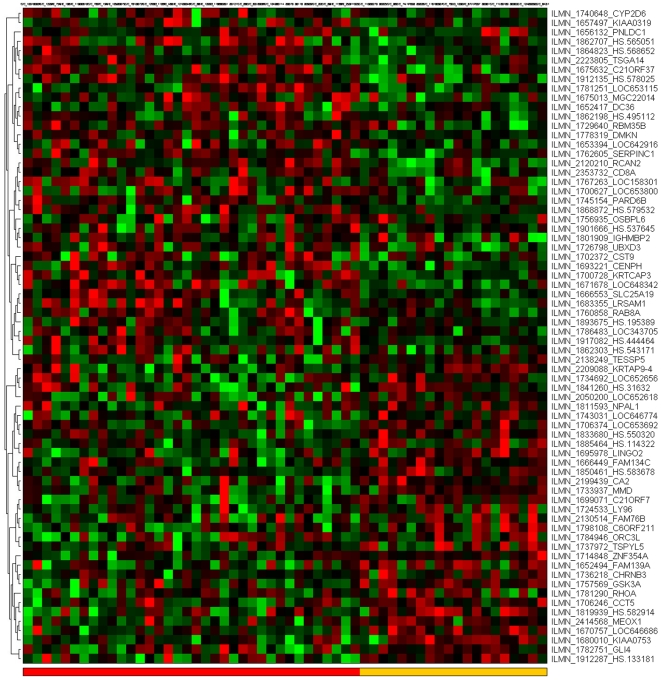
mRNA expression heatmap for the RR/SP signature.RRMS samples (red), SPMS (yellow).